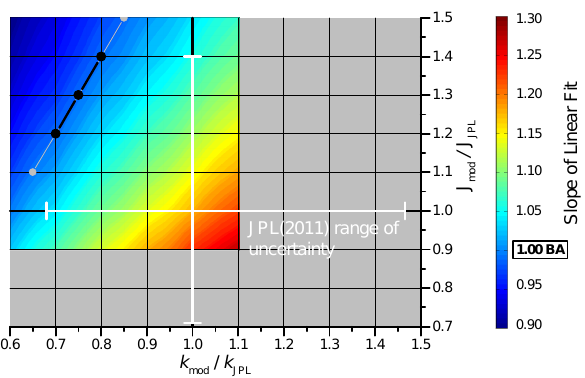
Fig. 8. Regression of J ( BrONO 2 ) versus k BrO + NO for the limb and 2 solar occultation BrO measurements together with the uncertainty range for both parameters as indicated by the JPL-2011 compila- tion. The colour coding indicates the resulting slopes of the mod- elled versus measured BrO SCD regression of the limb and solar occultation observations, when forcing the regression line through zero. The best agreement (BA) is given for a slope of 1. The results shown in Figs. 6 and 7 are represented by the black